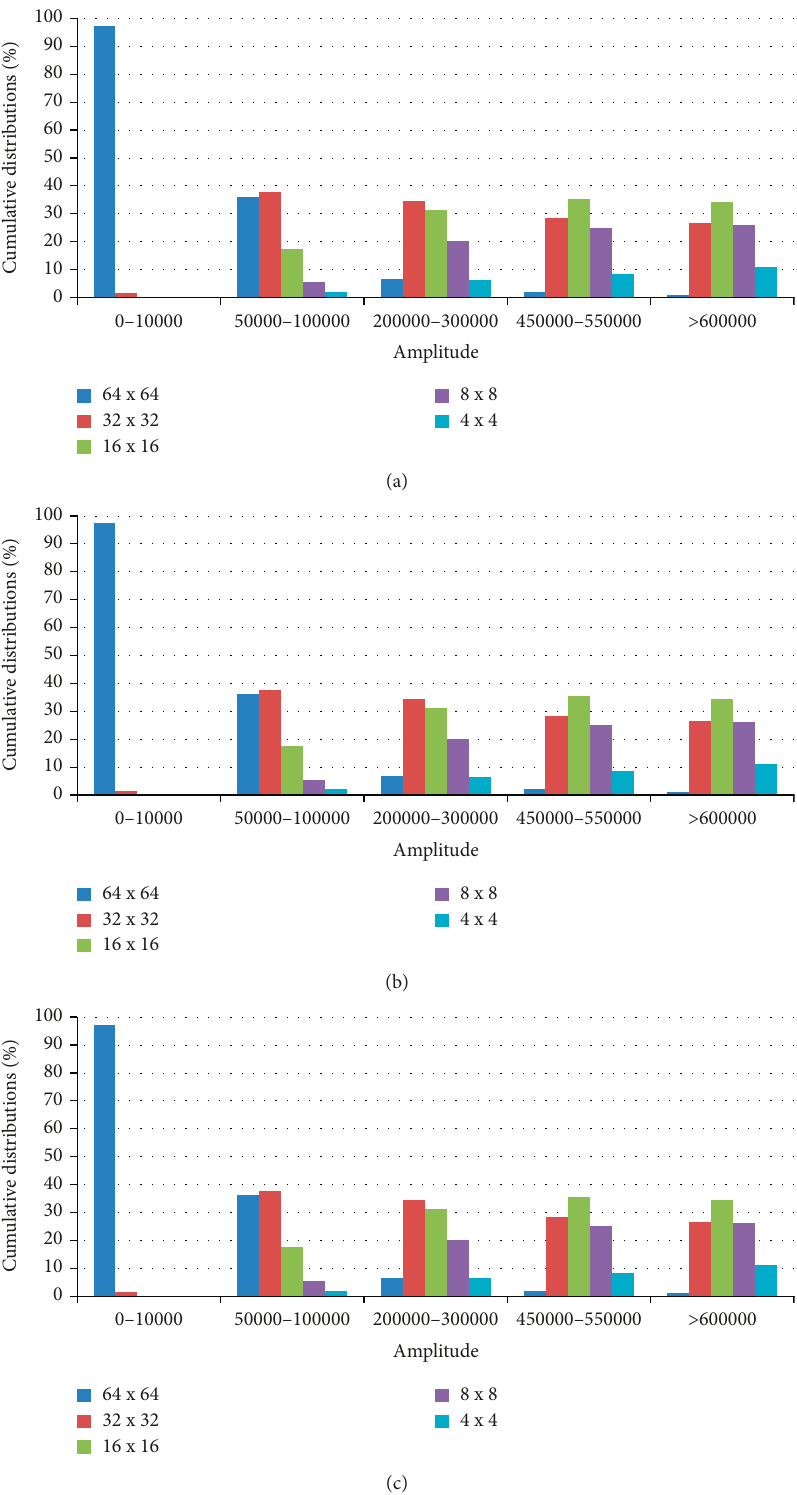
34, 39, and 42. (a) DepthMap